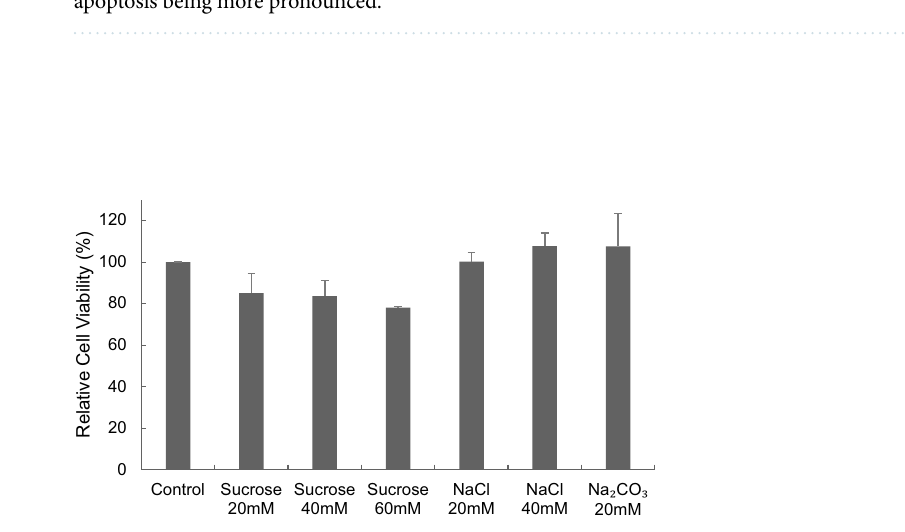
Figure 4. Mechanism of cell death induced by Sodium Phosphate Dibasic on MDA-MB-231 determined after 48 h of incubation with the phosphate compound. Live cells are shown in blue, apoptotic cells are shown in green and necrotic cells are shown in red. Sodium Phosphate Dibasic induces both necrosis and apoptosis, with apoptosis being more pronounced.